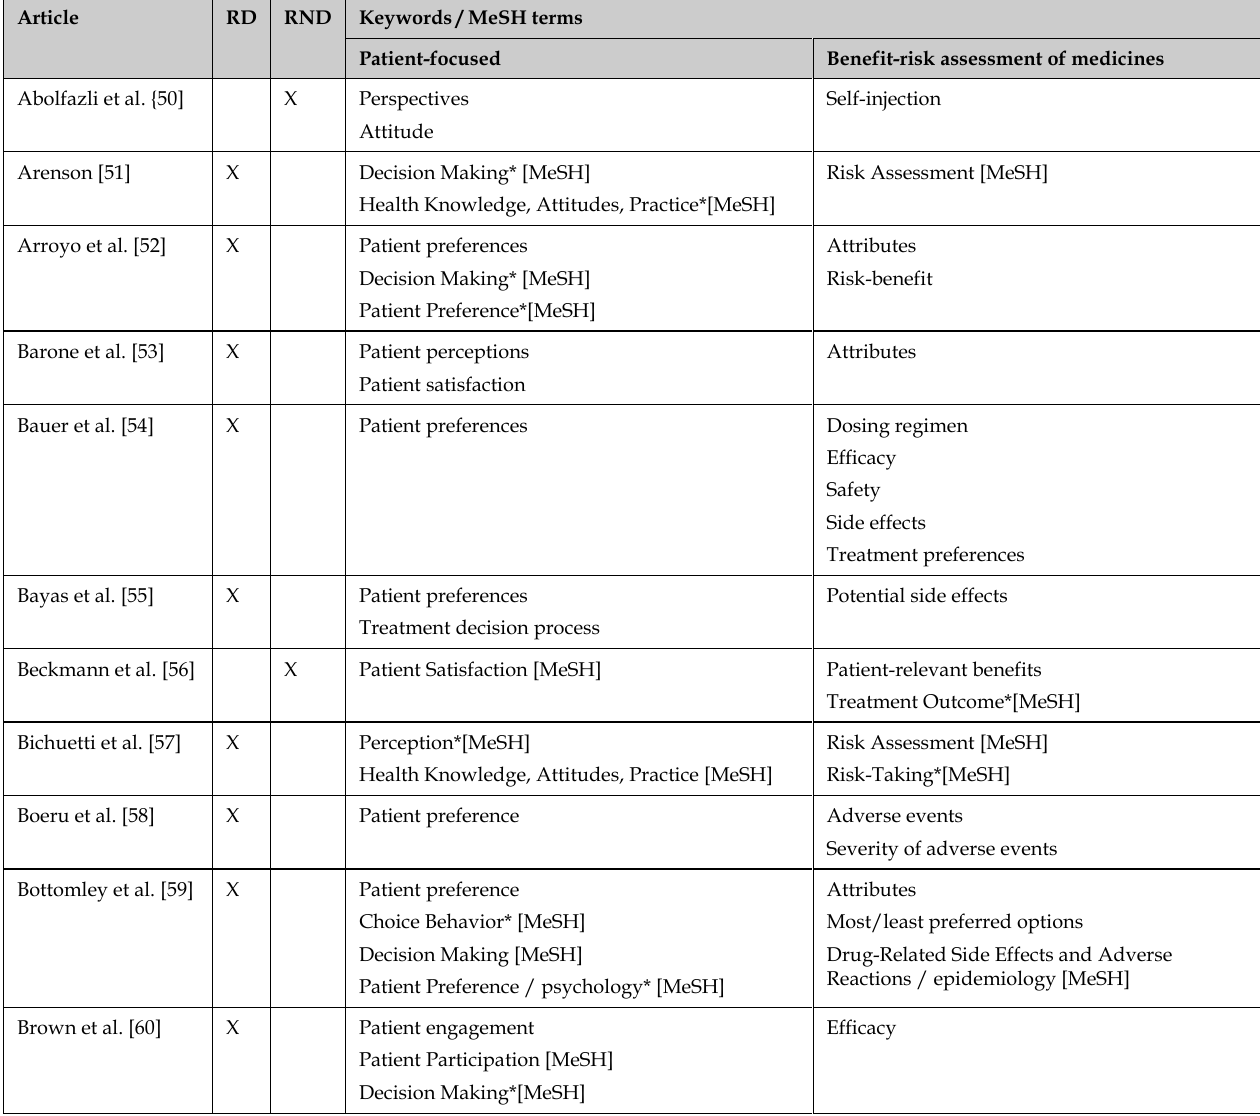
Table 3 Relevant articles on multiple sclerosis patients’ preferences regarding their medicines detected (RD) and not detected (RND) by the search strategy with corresponding keywords and MeSH